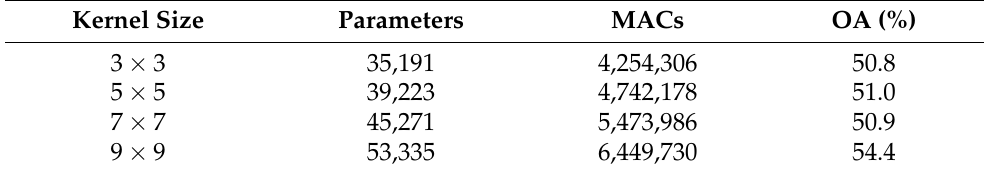
Table 6. Classification performance and the number of parameters and MACs of the proposed DRIN with different involution kernel sizes on the HyRANK dataset.